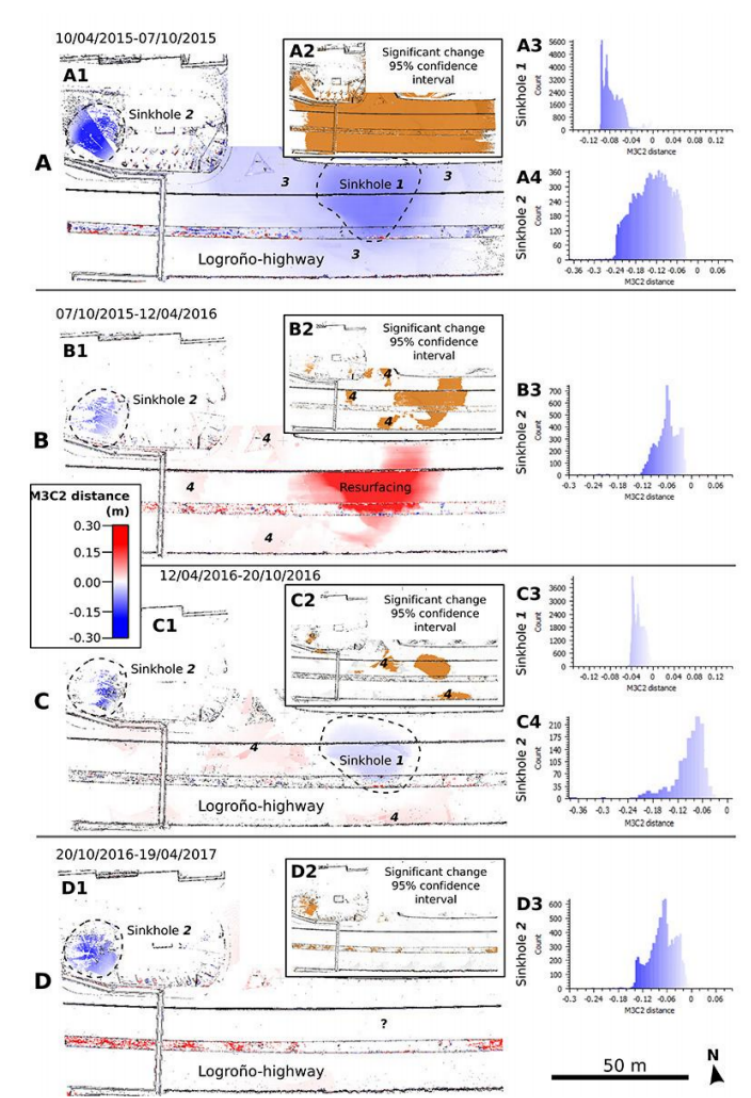
Figure 7. 4D monitoring of surface changes in the Logroño highway sinkhole, carried out between April 2015 and April 2017. ( A ) Changes from 10/04/2015 to 07/10/2015 (180 days). ( B ) Changes from 07/10/2015 to 12/04/2016 (188 days). ( C ) Changes from 12/04/2016 to 20/10/2016 (191 days). ( D ) Changes from 20/10/2016 to 19/04/2017 (181 days). Surface-change frequency histograms are shown on the right of the displacement